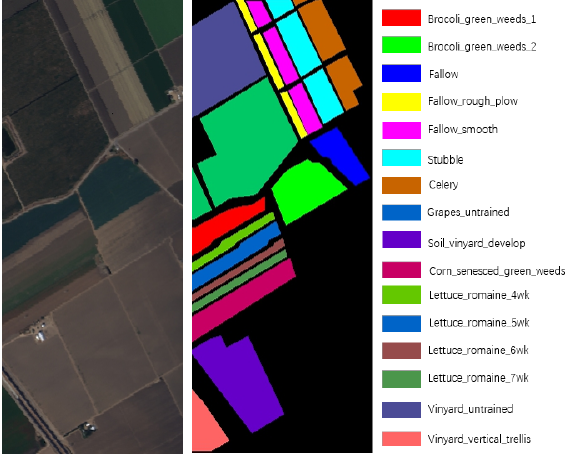
Figure 6. University of Pavia: false-color image and ground-truth map.